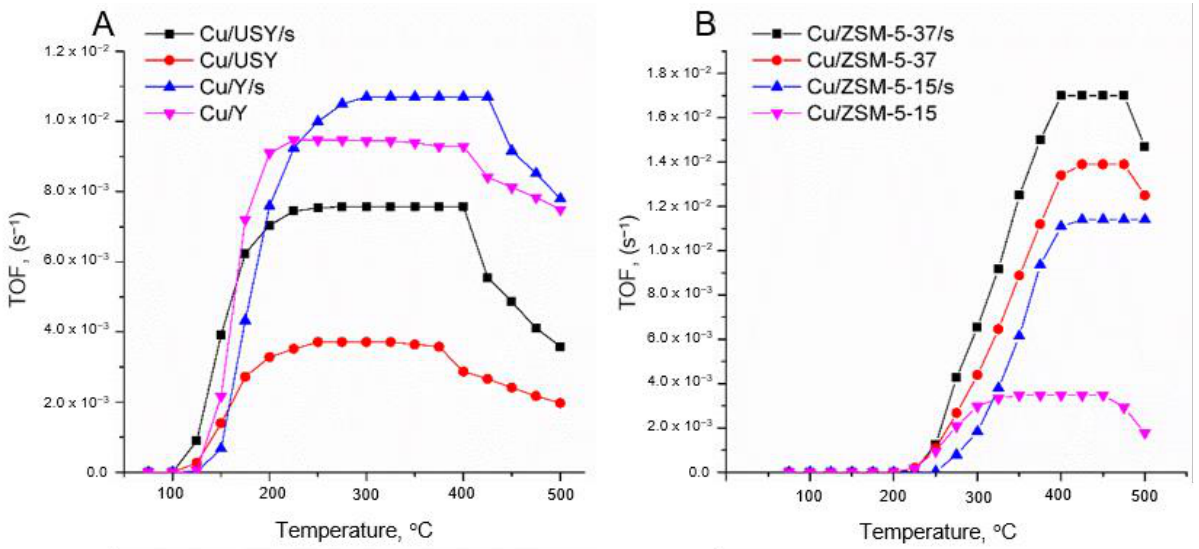
Figure 5. Reaction rate expressed as TOF: ( A ) Cu/Y and Cu/USY samples, ( B ) Cu/ZSM-5-15 and Cu/ZSM-5-37 samples.